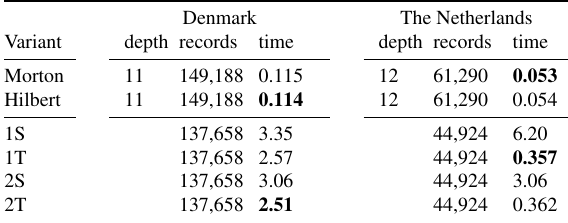
Table 3. Query time comparison. Time in seconds. Fastest